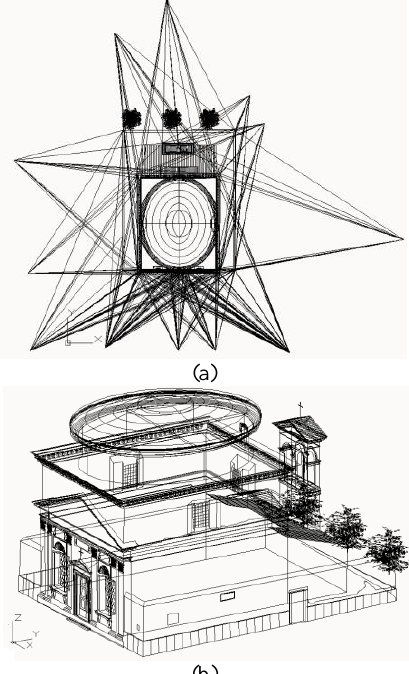
Figure 21 . Sant’Andrea in Tiziano alley by Vignola a) control network, the arrangment of the twelve panoramas, b) 3D model (plot by GL Rubeca